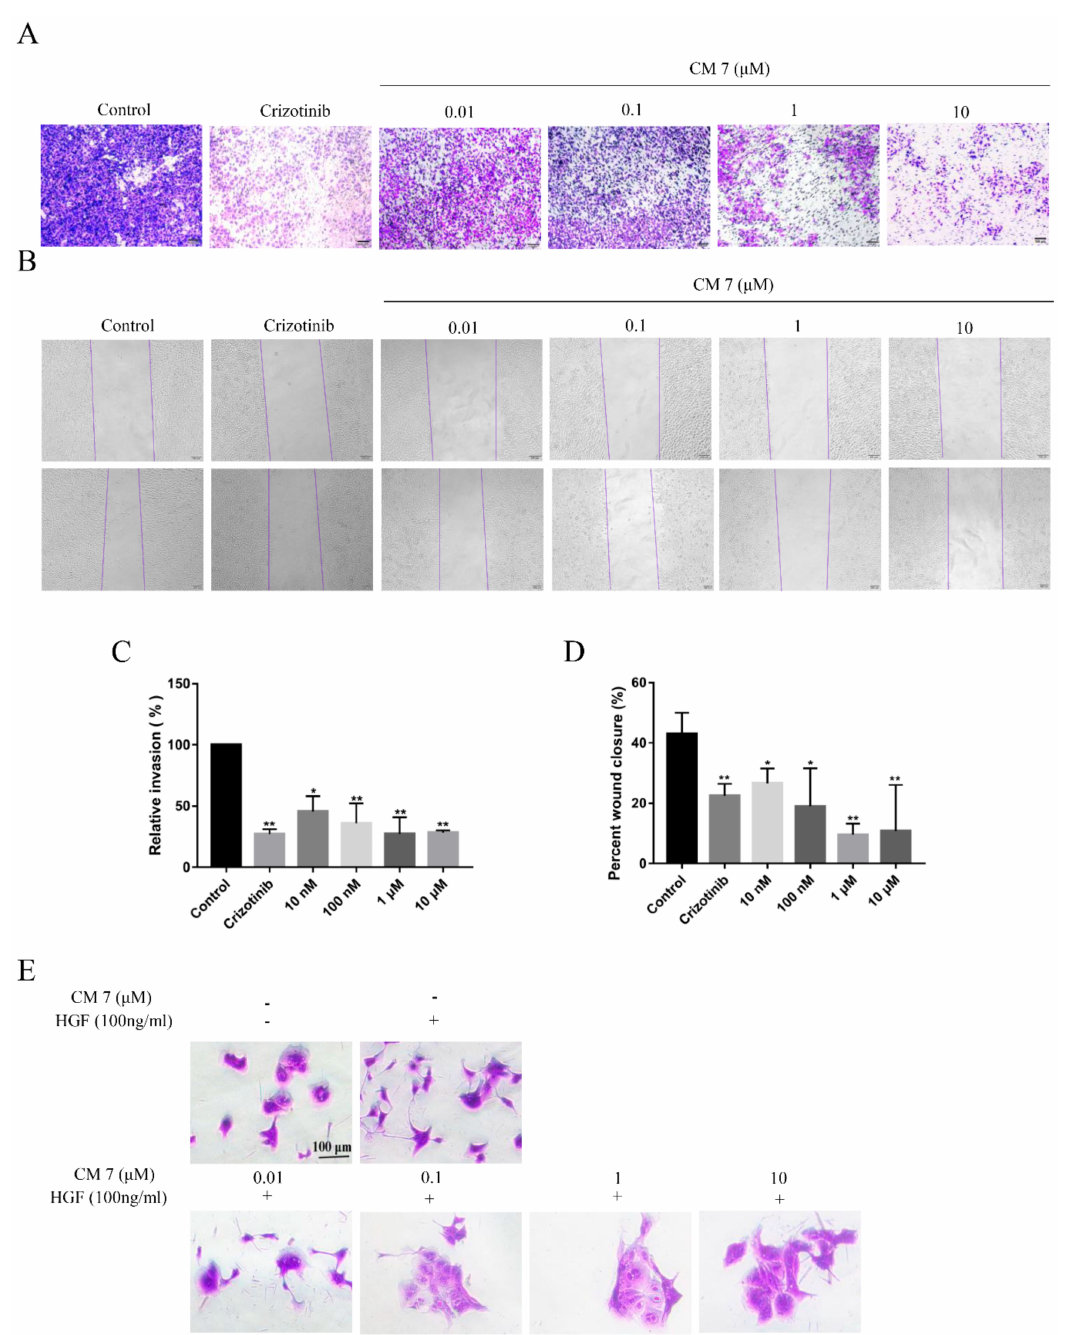
Figure 7. CM 7 suppresses c-Met-mediated cell invasion, migration, and scattering. ( A ) The invasion ability of MKN-45 cells was weakened by CM 7. ( B ) The migratory ability of MKN-45 cells was impaired by CM 7; the top is 0 h, and the bottom is 48 h. ( C , D ) Representative histograms of relative cell invasion or migration of MKN-45. Results are presented as mean ± SD (n = 3). * p < 0.05, ** p < 0.01 vs control, one-way ANOVA with multiple comparisons. ( E ) MDCK cell scattering induced by HGF was dose-dependently inhibited by CM 7. Representative images from three separate experiments are shown. In all of the pictures shown in this figure, scale bars = 100 µ